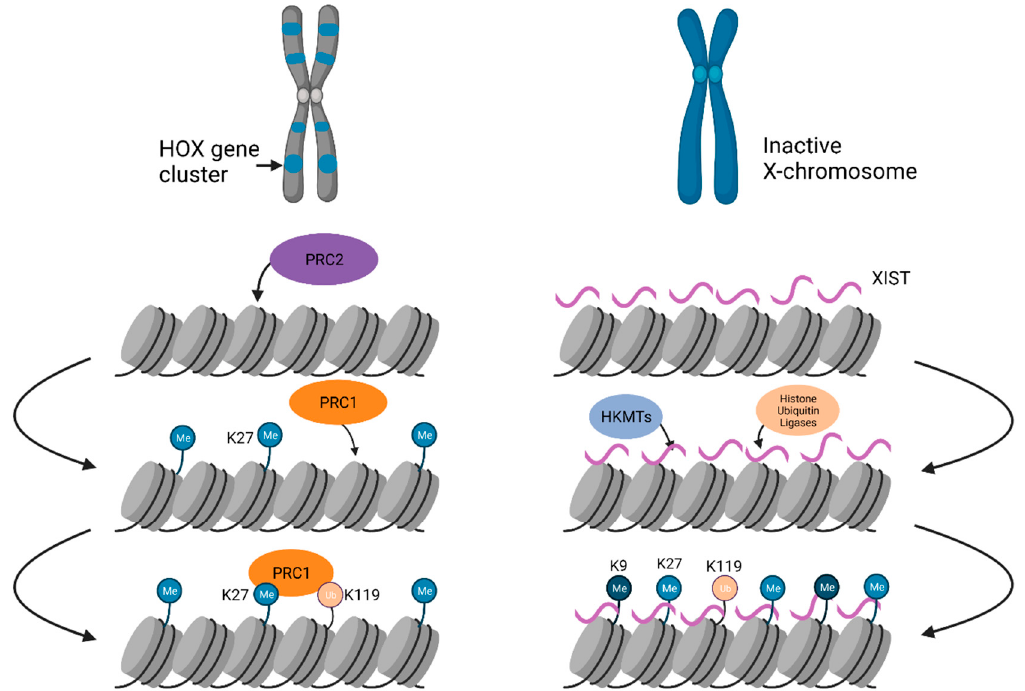
Figure 4. Establishment of facultative heterochromatin. Left–domain-wide facultative heterochromatin formation on developmentally regulated loci such as HOX gene clusters distributed throughout chromosomes. PRC1 deposits H3K27me, which is recognized by PRC2 that catalyzes H3K27me3 and H3K119ub formation on these domains. Right–chromosome-wide facultative heterochromatin over an entire Xi. The lncRNA Xist binds to the X-chromosome, which then recruits PcG proteins, HMTs, and histone ubiquitin ligases to deposit H3K119ub, H3K9me, and H3K27me modifications to establish compact heterochromatin.